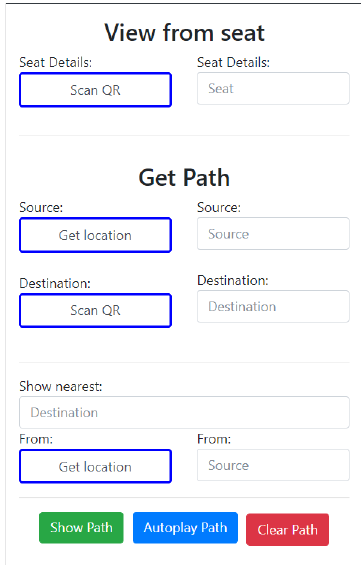
Figure 5. Options available.